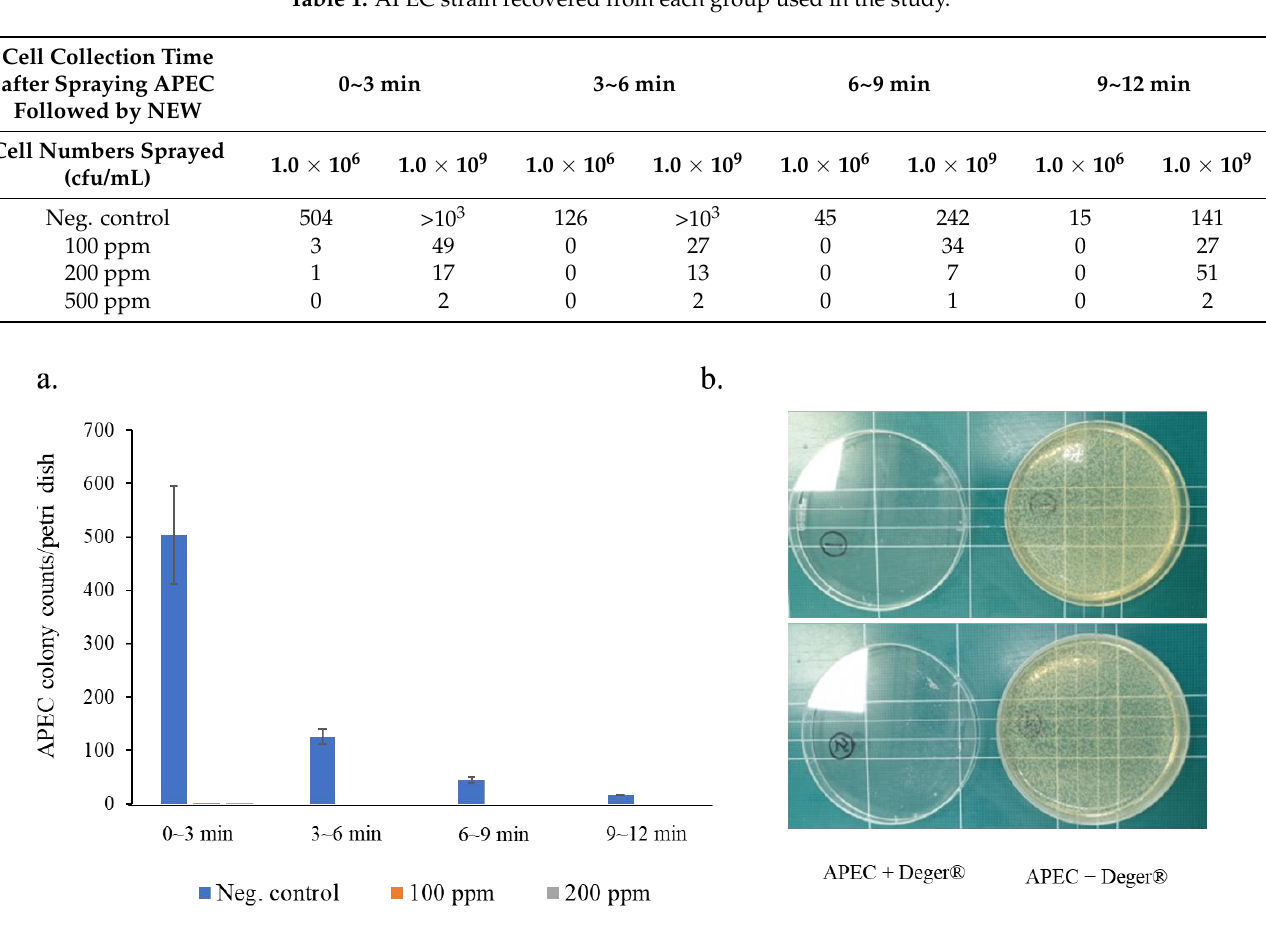
Figure 4. Effective concentrations of NEW on the anti-survival of APEC strains in the air. The number of cells was determined for 3 min after spraying APEC followed by NEW up to 12 min. APEC strains in the chambers were perceptibly decreased up to 12 min according to increased NEW concentrations ( a ). The viable cells were recovered from groups treated with and without NEW. Fifty mL of APEC strains (1.0 × 10 6 cfu/mL) in the experimental chambers was considerably reduced from 3 min after spraying 50 mL of 100 ppm NEW. The pictures show the 99.9% reduction in APEC by spraying NEW ( b ).